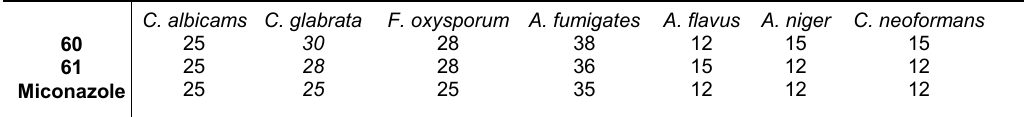
Figure 23. Antifungal coumarins synthesized under solvent-free conditions and exploiting ionic liquid as catalyst.